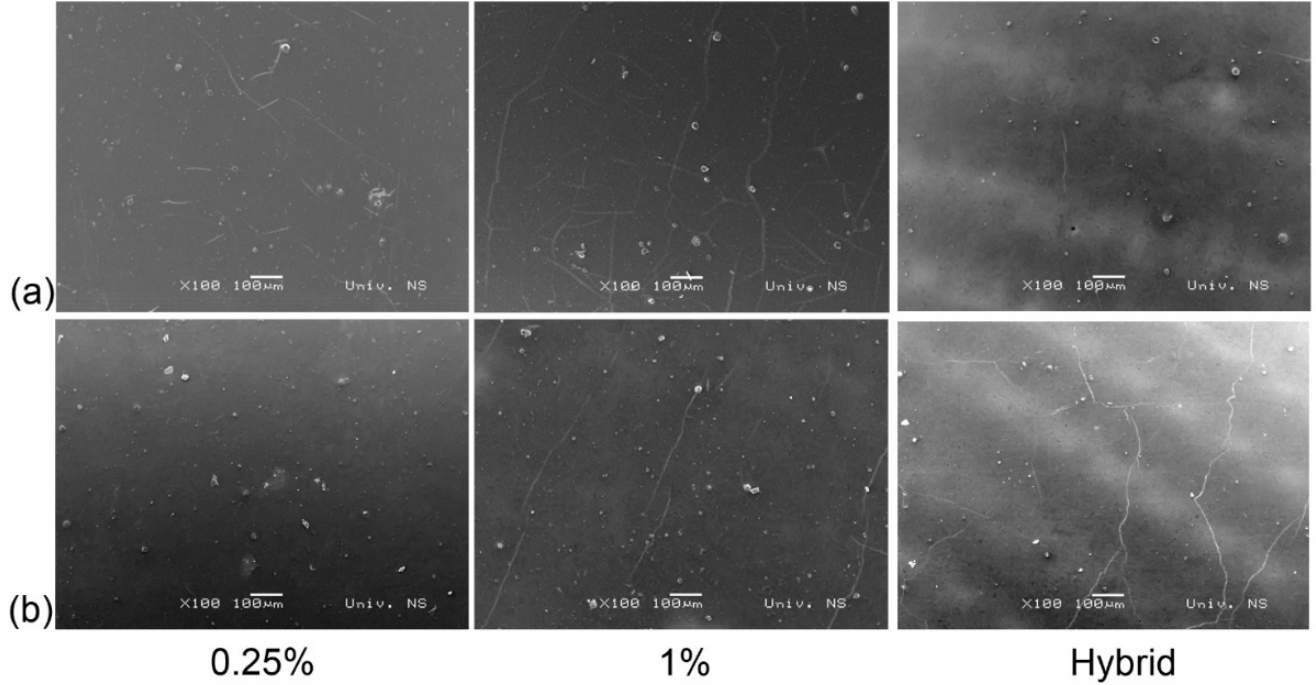
Figure 2. SEM micrographs of samples coated by nanocomposite containing ( a ) ZnO and ( b ) TiO 2